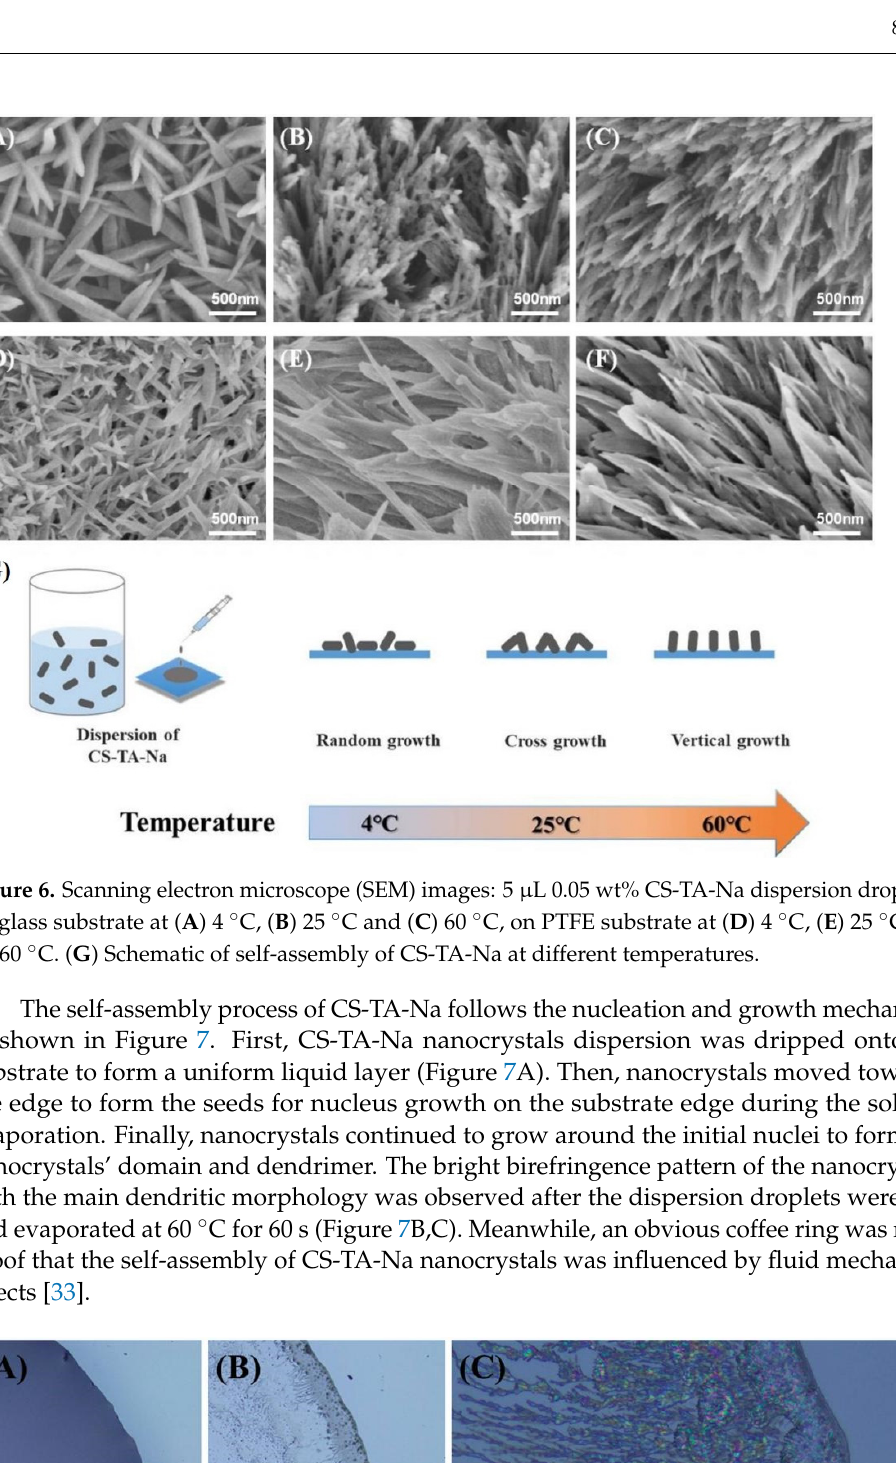
8 of 11 Figure 5. Photo of ( A ) CS-TA-Na powder and ( B ) its aqueous solution. ( C ) Transmission electron microscope (TEM) image of CS-TA-Na nanocrystals. Figure 6 demonstrates the morphologies of self-assembled CS-TA-Na on glass and PTFE substrate at 4 °C, 25 °C and 60 °C, respectively. As shown in Figure 6G, the morphologies presented a dependence on the water evaporation rate and the surface characteristics of the substrate. When the water evaporation was slow (at 4 °C), CS-TA-Na had ample time to adjust and self-assemble, resulting in a more ordered structure. The assembled nanorods were more than 1 μ m in length and 50 nm in width (Figure 6A,D) [31]. When the air-drying temperature increased, those dispersed CS-TA-Na nanocrystals tended to assemble quickly and interlace. At 25 °C, interlaced nanorods and nanosheets were observed (Figure 6B,E). Further increasing the drying temperature to 60 °C could lead to the flower-like pattern composed of vertical